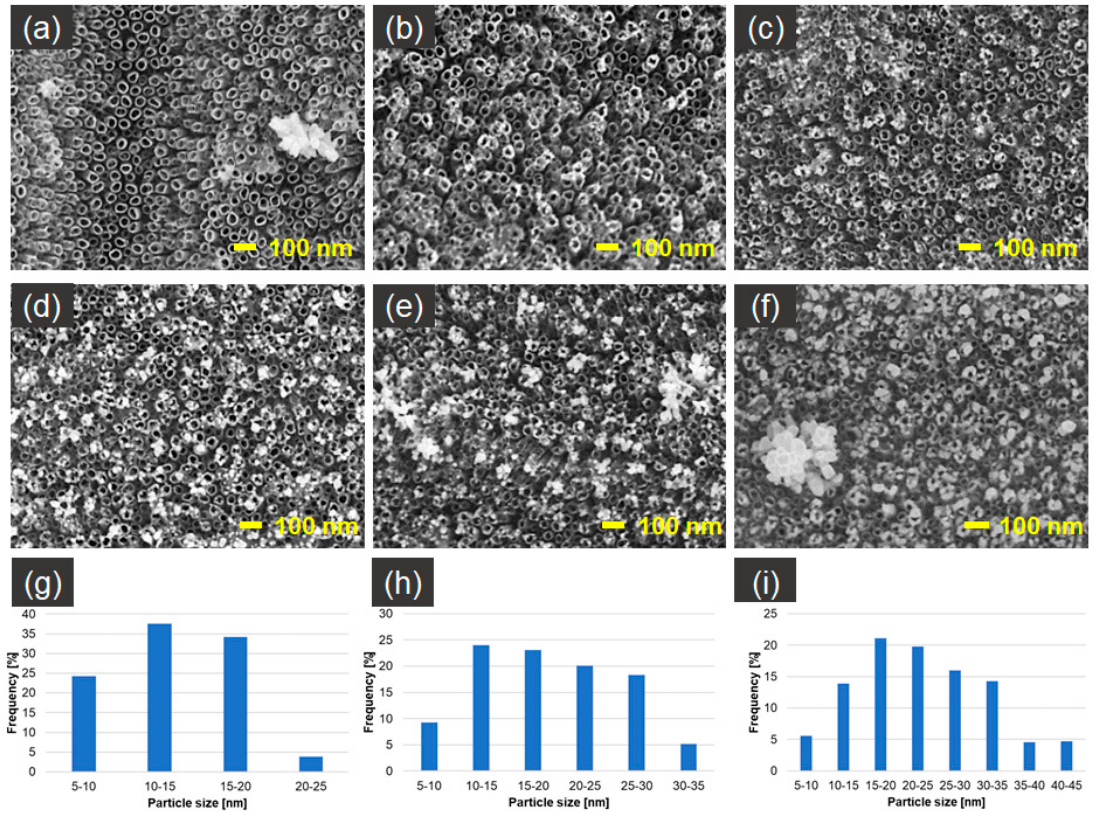
Figure 5. SEM top-view images of AgNPs/TNT platforms prepared by chronoamperometry for: ( a ) 30 s, ( b ) 60 s, ( c ) 120 s, ( d ) 180 s, ( e ) 240 s, ( f ) 300 s and histograms of particle-size distribution for: ( g ) 60 chrono_ AgNPs/TNT, ( h ) 120 chrono_ AgNPs/TNT, ( i ) 180 chrono_